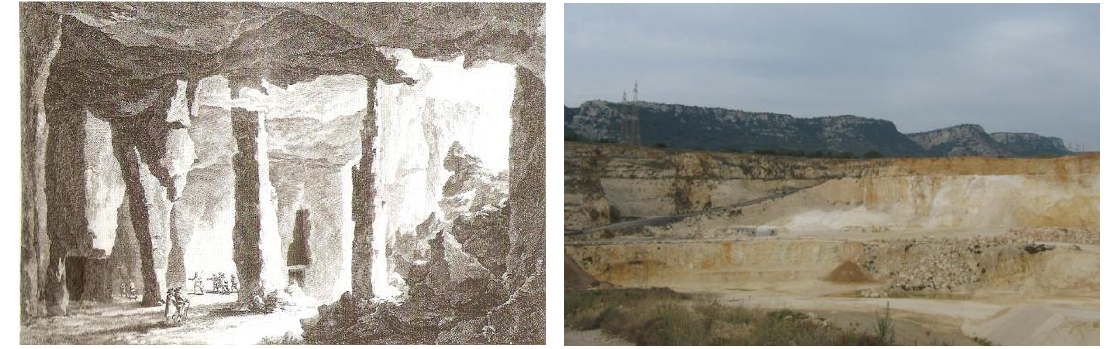
Figure 1. Etched engraving of Latomie and new Priolo quarry (SICS).